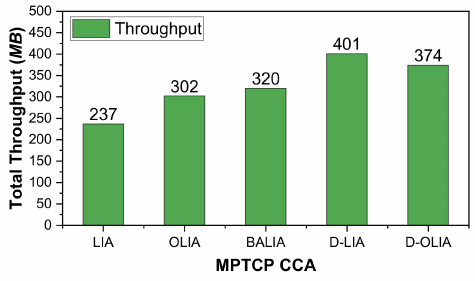
Figure 9. Performance of the considered MPTCP-CCAs for Scenario #3 in terms of total throughput.